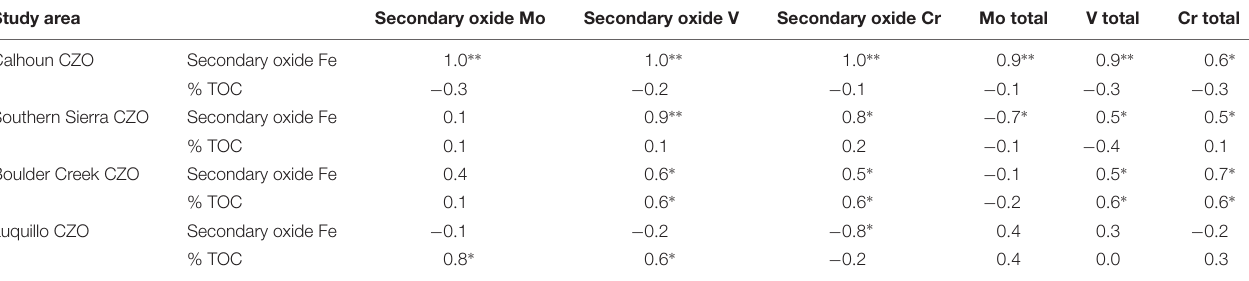
TABLE 2 | Pearson correlation coefficients for linear regressions between secondary Fe oxide and %TOC with secondary Fe oxide and total Mo, V, and Cr at each of the four CZOs. Study area Secondary oxide Mo Secondary oxide